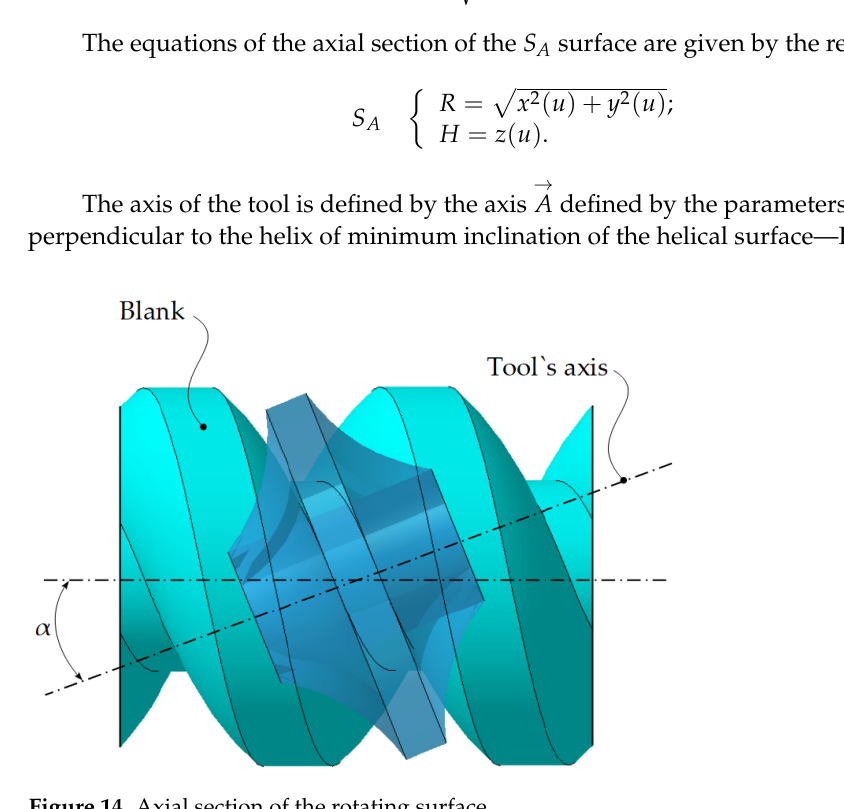
Figure 14. Axial section of the rotating surface.